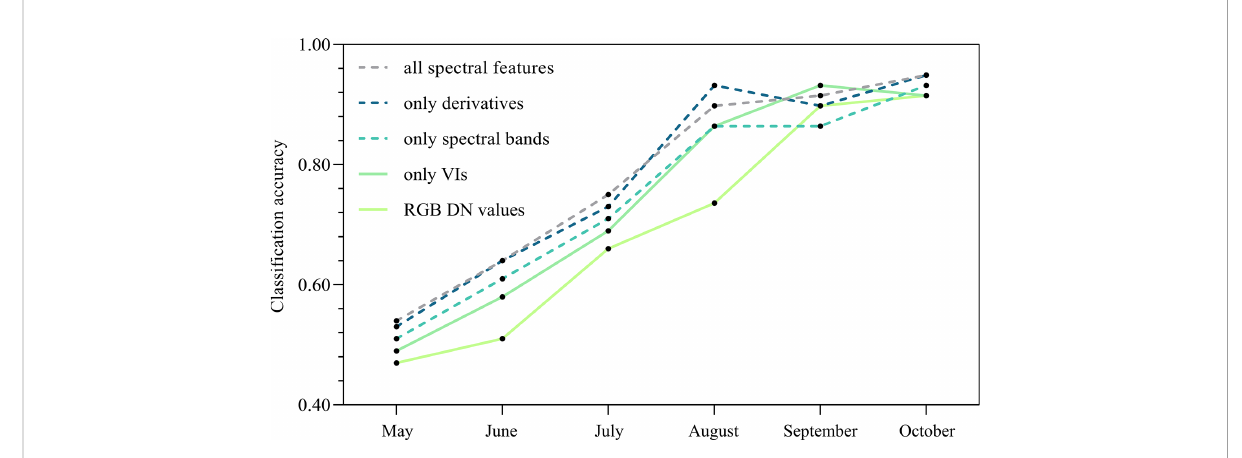
FIGURE 10 Classi fi cation accuracy for distinguishing infested and control trees by using different types of features during the course of pine wilt disease